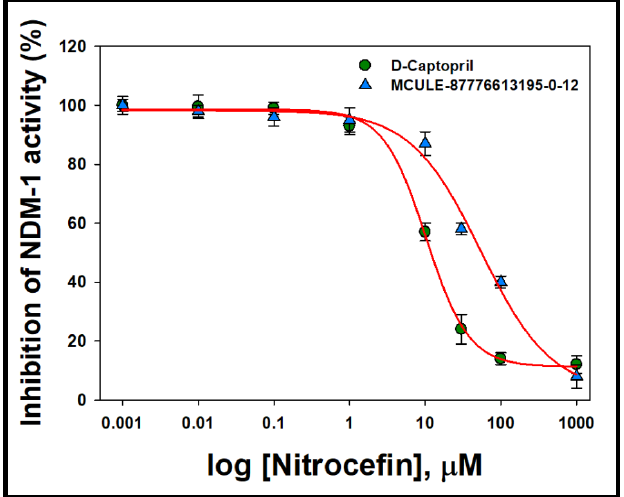
Figure 6. The IC 50 curves of NDM-1 in the presence of D-captopril (known inhibitor) and MCULE-